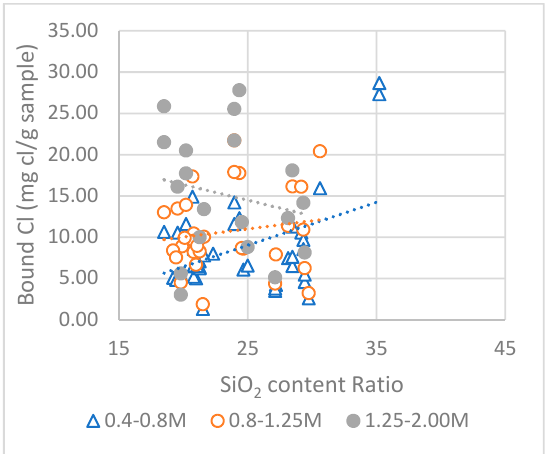
Figure 10. Relation between SiO 2 ratio and bound chloride for different chloride concentrations for all data.